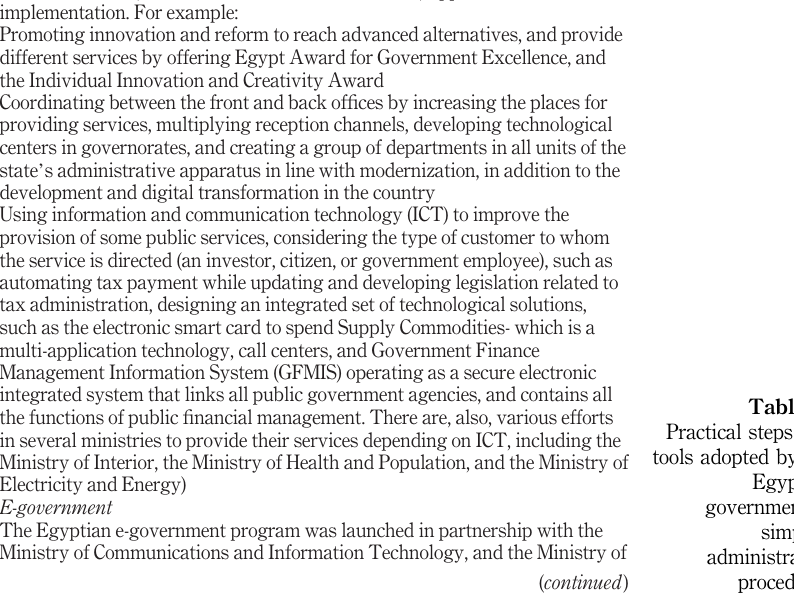
Table 2. Practical steps